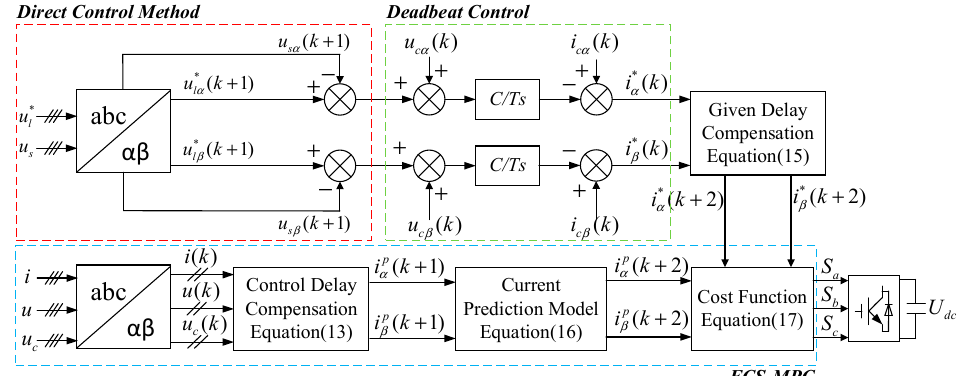
Figure 4. Predictive current control diagram after delay compensation.